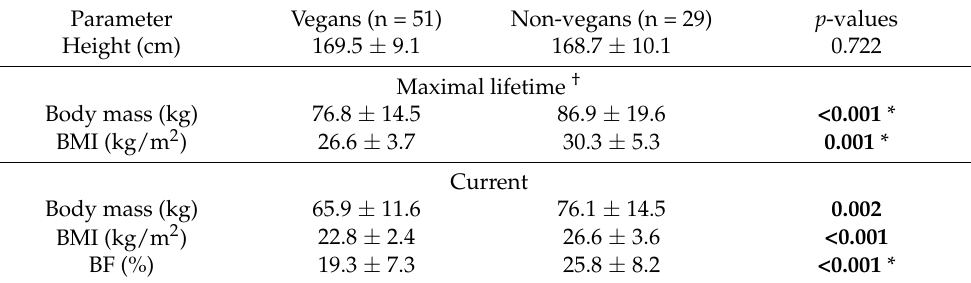
Table 1. Body composition